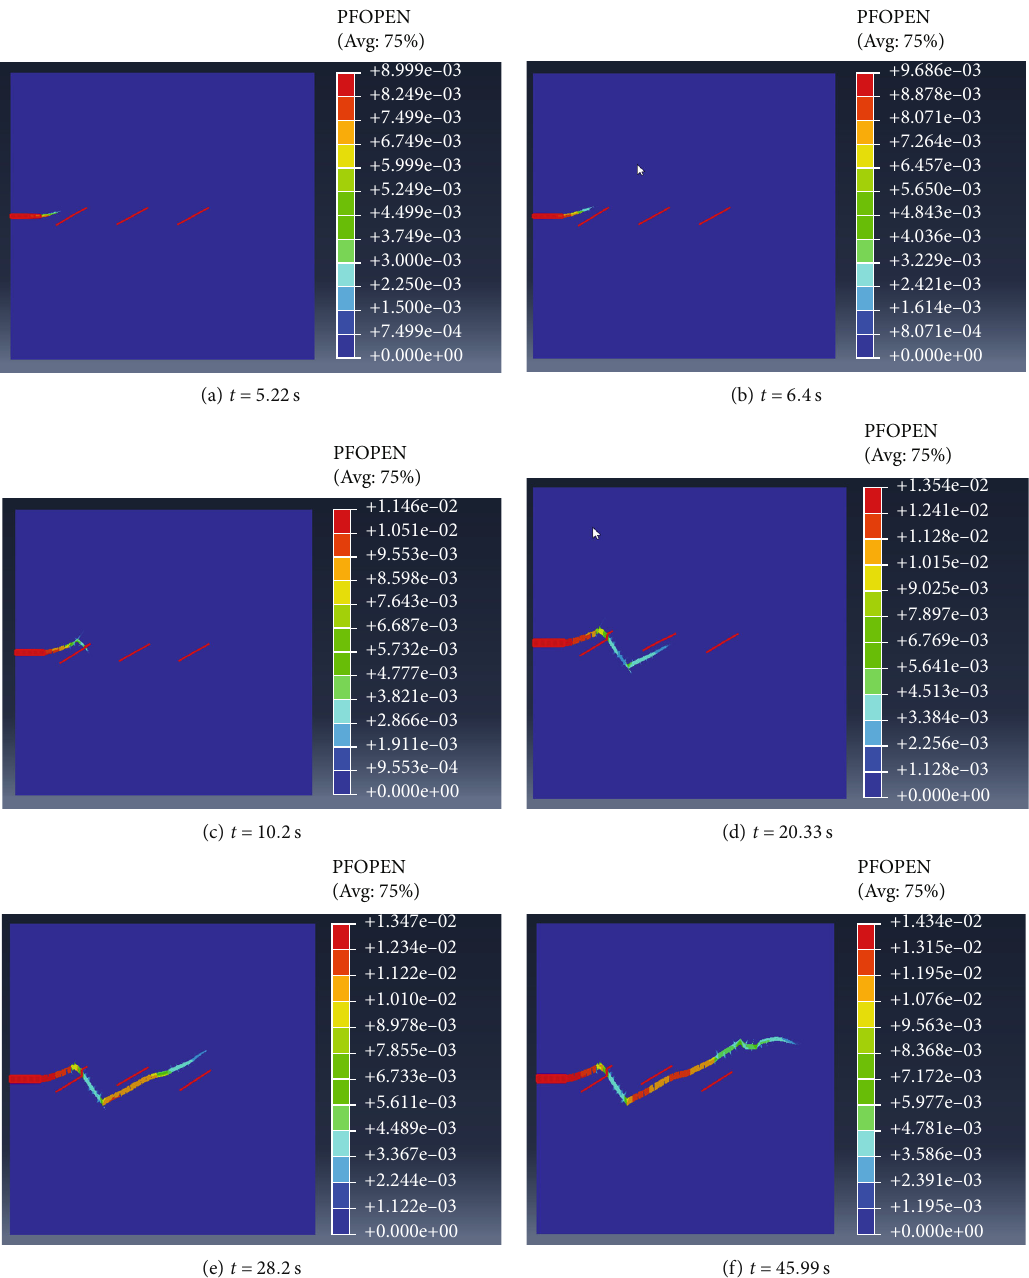
Figure 25: HF propagation at the NF approaching angle of 45 ° and stress anisotropy coe ffi cient of